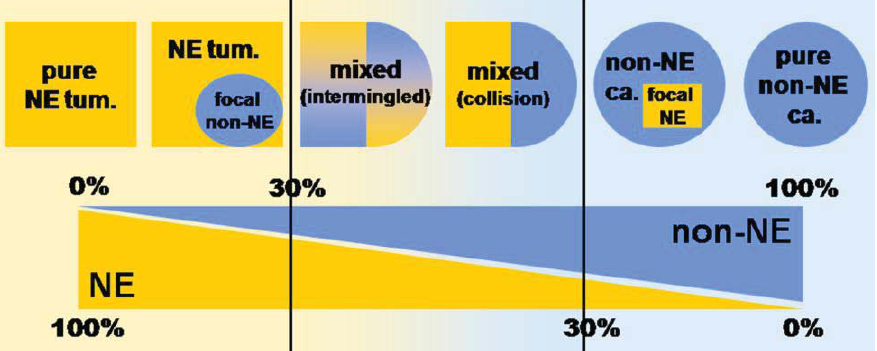
Figure 1. Schematic representation showing the wide spectrum of combinations of exocrine and neuroendocrine components in human tumors, ranging from neuroendocrine neoplasms with a focal exocrine component at one extreme (left) to exocrine carcinomas with interspersed neuroendocrine cells at the other (right). However, mixed exocrine-neuroendocrine tumors (middle) are only those neoplasms in which each component represents at least 30% of